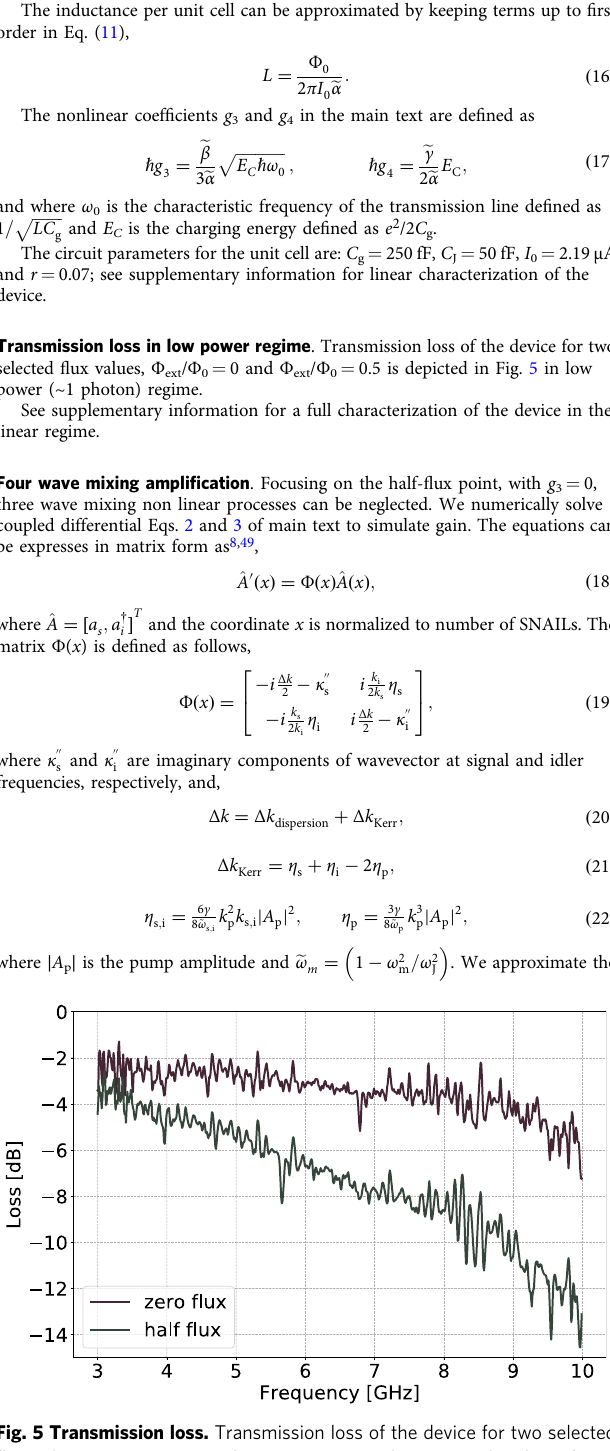
Φ = 0 and Φ ext / 0